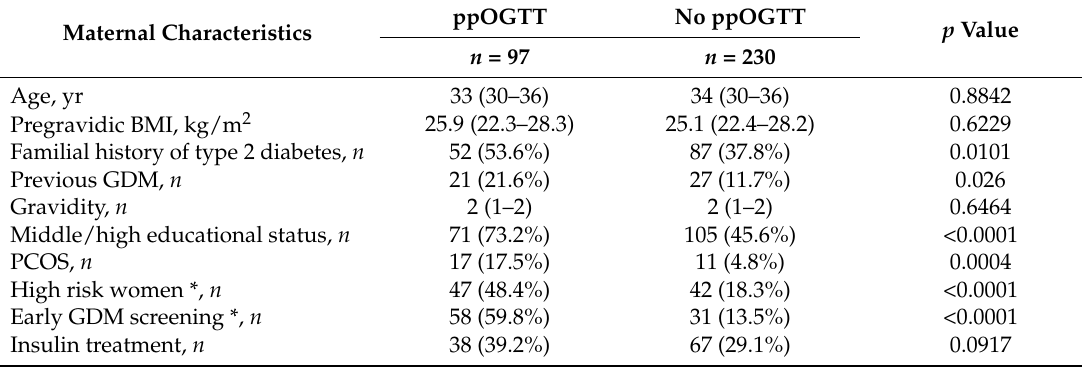
Table 1. Characteristics of the enrolled women who had, or had not performed